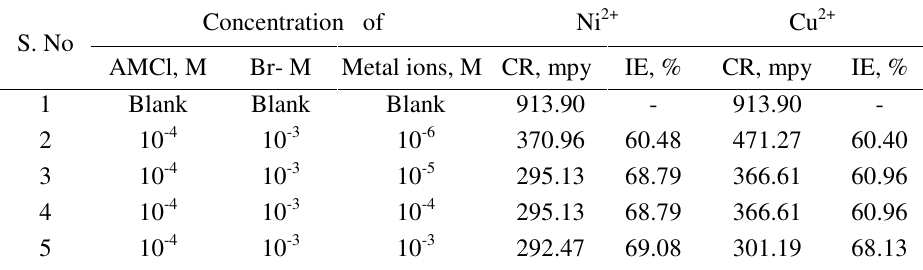
SO (5 h study) 2 4